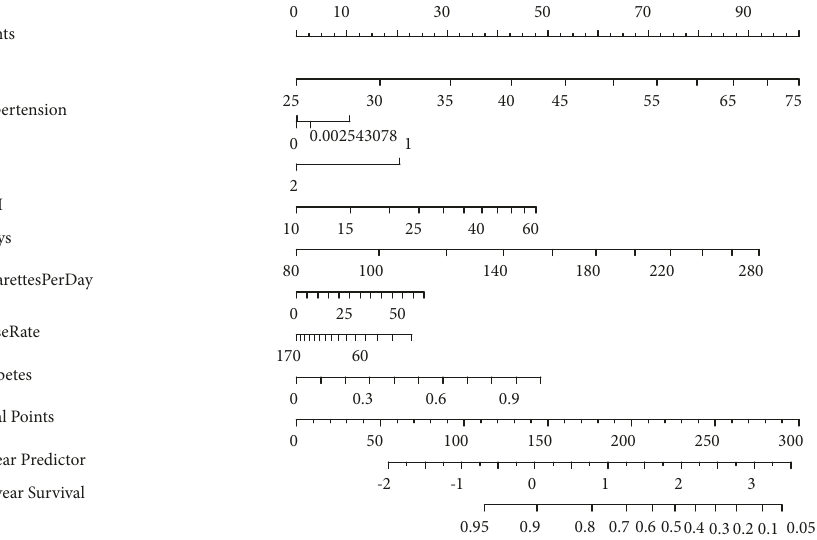
Figure 1: Nomogram for predicting overall survival in 10 years.